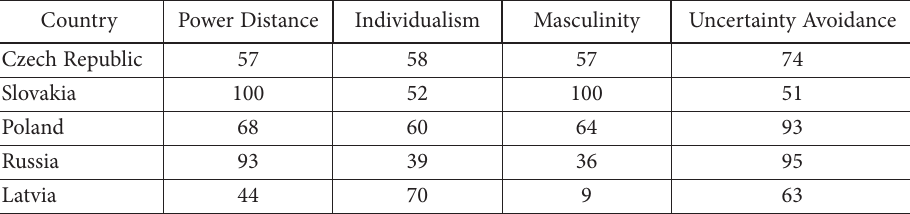
Table 1. Values of Hofstede’s dimensions of national culture for the selected post-communist countries in Europe (source: Hofstede Insights, 2020) Country Power Distance Individualism Masculinity Uncertainty Avoidance Czech Republic 57 58 57 74 Slovakia 100 52 100 51 Poland 68 60 64 93 Russia 93 39 36 95 Latvia 44 70 9